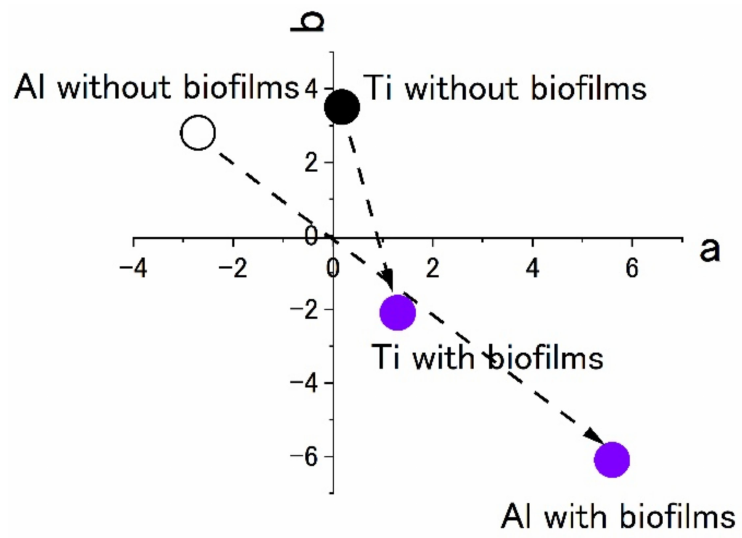
Figure 7. The color changes in specimens’ surfaces stained by 0.1% crystal violet in the SDRBR. (a) complementary color dimension between red and green. (b) complementary color dimension between yellow and blue.